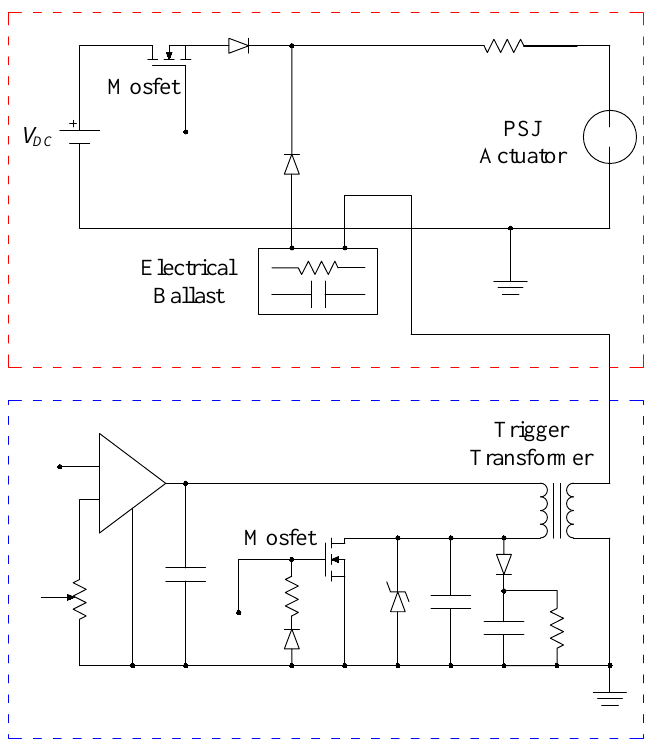
Figure 3. Power supply system: the sustain circuit (top) and the trigger circuit (bottom)